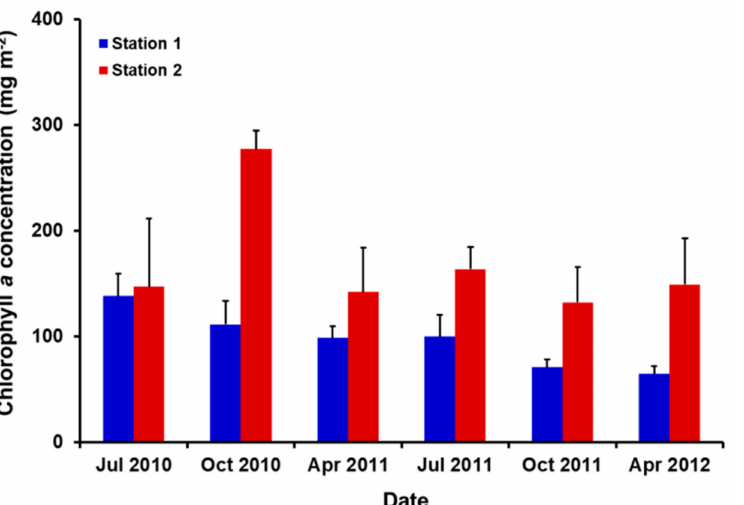
Figure 2. Chlorophyll a concentration as a proxy for the biomass of benthic diatoms (chlorophyll a mg m − 2 ) in all soft bottom samples and normalized to a sediment surface area of 1 m 2 , as measured at two stations that differed in depth (S1: 11–49 cm; S2: 2–12 cm). Sampling took place between July 2010 and April 2012. The data are given as mean values with standard deviation ( n = 3). Different letters reflect significantly different mean values (Tukey’s test, p <